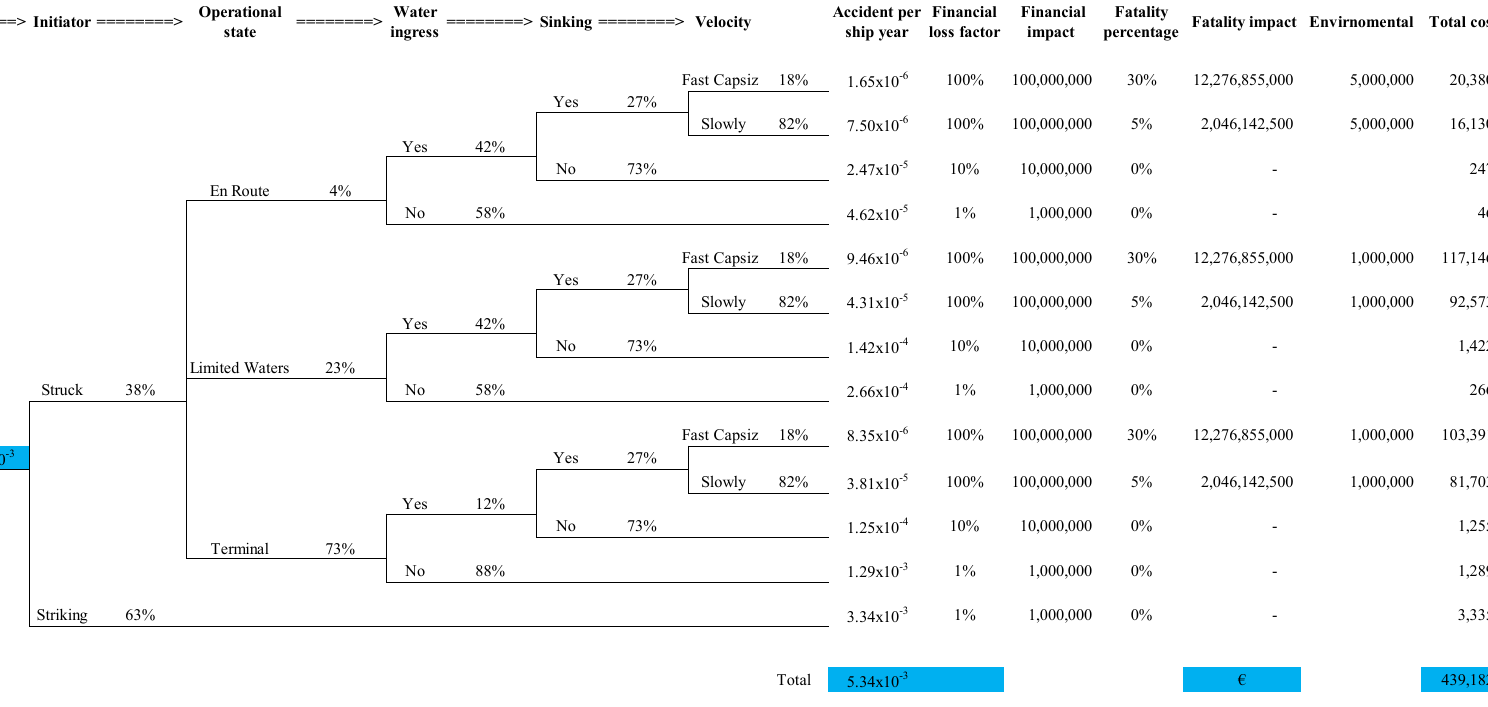
Figure 12. Event tree analysis of collision for passenger ships.